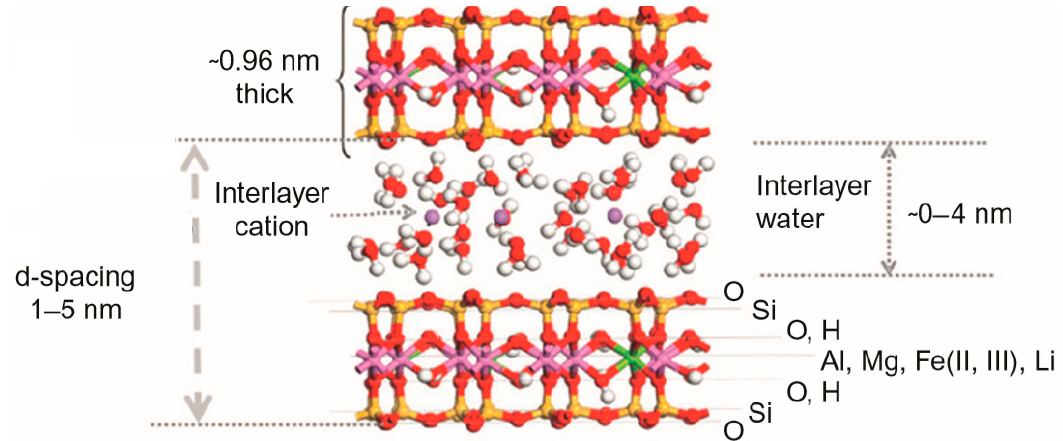
Figure 10. Diagrammatic representation of a three-layer hydrate. Reproduced with permission from the authors of [44] .